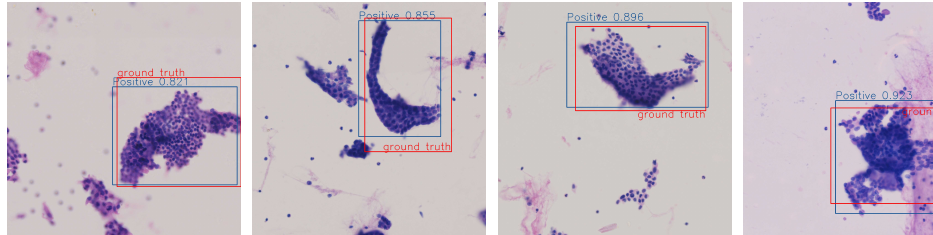
Figure 7. Some examples of the detection results.